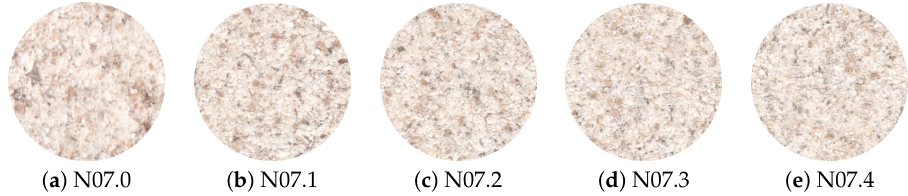
Figure 7. Samples of cultivar N07, the lowest accuracy of barley flour